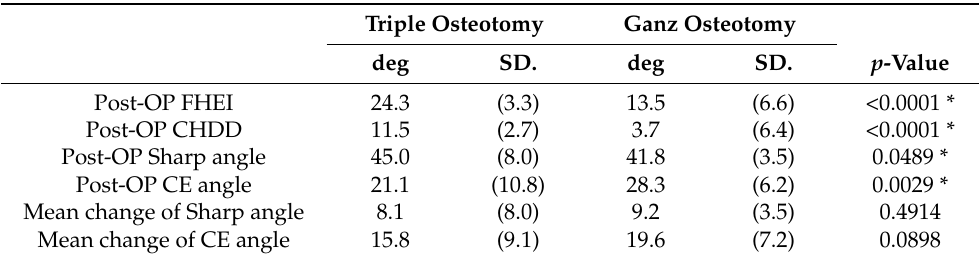
Table 3. Comparison of correction in radiographic parameters between the Triple osteotomy group and Ganz osteotomy